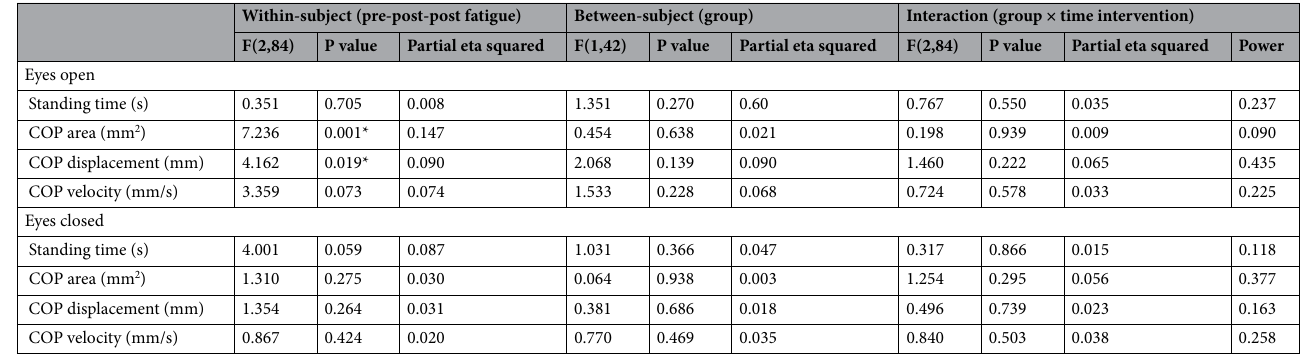
Table 4. Statistical results of the balance data among the three groups on soft-mat with eyes open and eyes closed condition. * p < 0.05.